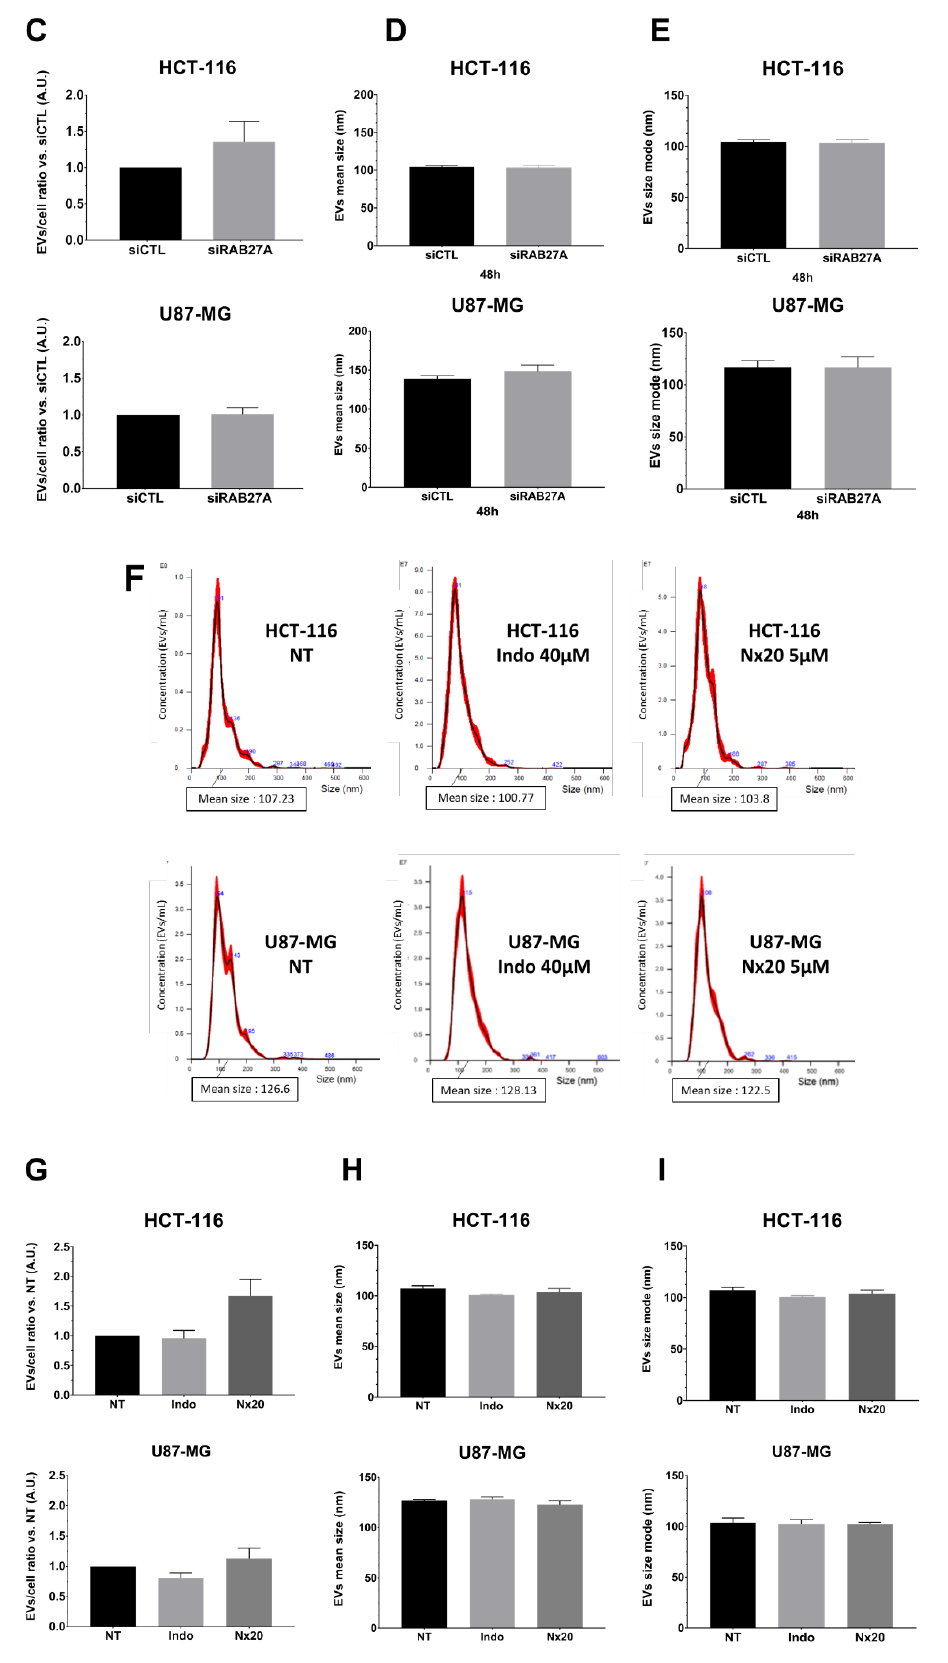
Figure 3. NTA analysis following different attempts for EVs secretion alteration in HCT-116 and U87-MG cell lines. ( A )—Downregulation of RAB27A expression using siRAB27A was evaluated